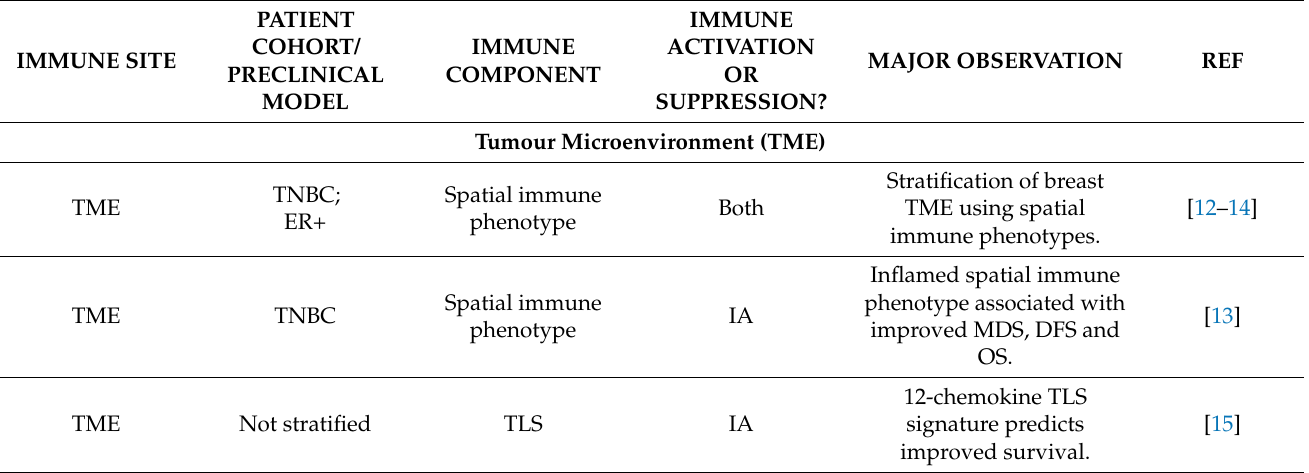
Table 1. Studies characterising the immune profiles of the tumour microenvironment, the peripheral blood and the lymph